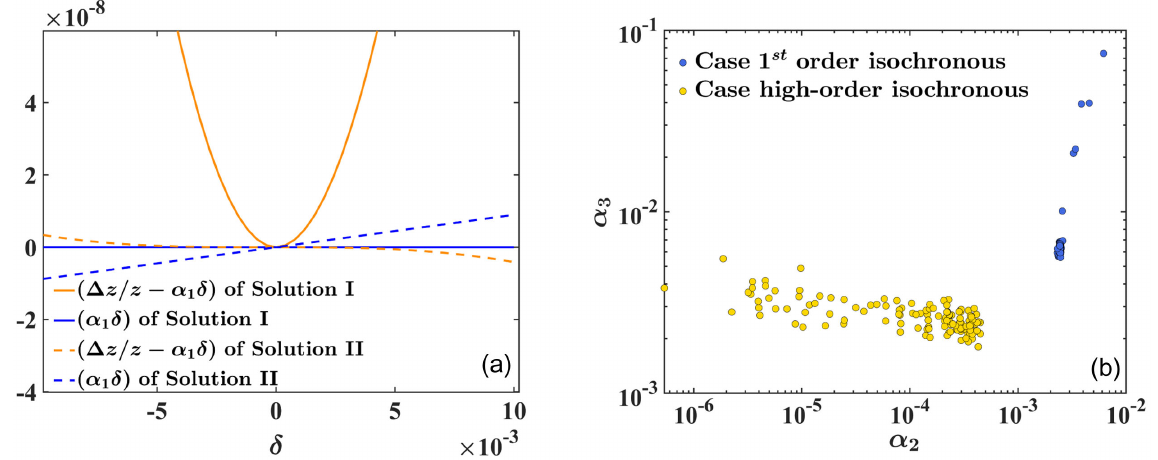
FIG. 7. (a) α 1 δ (blue) and Δ z=z − α 1 δ (yellow) of Solution I (solid line) and Solution II (dashed line). (b) The α 2 and α 3 term of the selected solutions with j α 1 j < 1 × 10 − 5